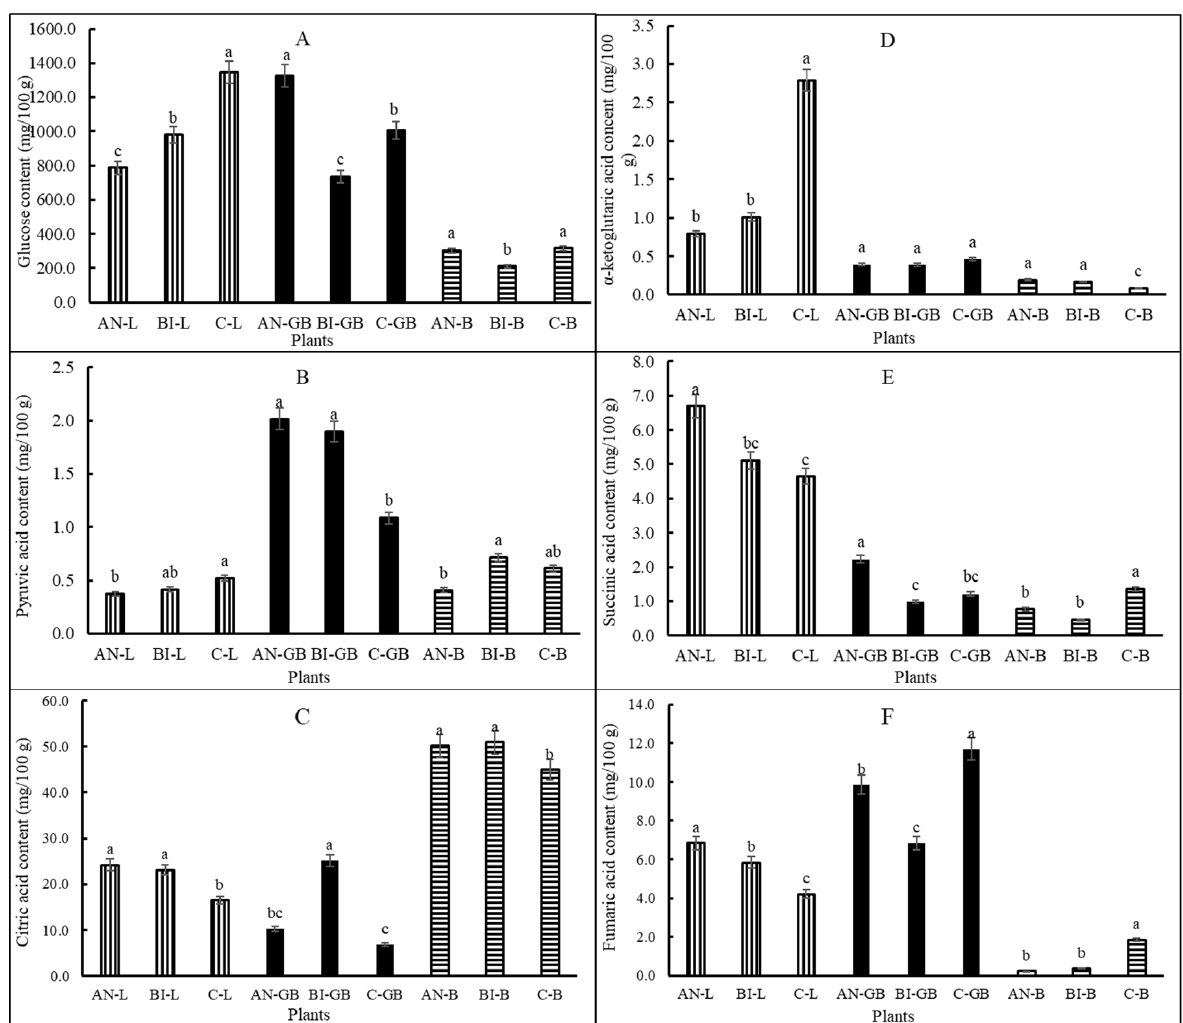
Figure 4. Plant metabolites of the tricarboxylic acid cycle as influenced by application of municipal solid waste compost at varying application frequency. Bars with vertical lines represent lettuce, solid black bars represent green beans and bars with horizontal lines represent beets; C-L, C-GB and C-B represent lettuce, green bean and beets grown with no compost (control), respectively; BI-L, BI-GB and BI-B represent lettuce, green bean and beets grown with biennial compost application, respectively; and AN-L, AN-GB and AN-B represent lettuce, green bean and beets grown with annual compost application, respectively; ( A – F ) is panel label. Differences in the letters on bars indicate significant differences at p < 0.05 (N = 9).